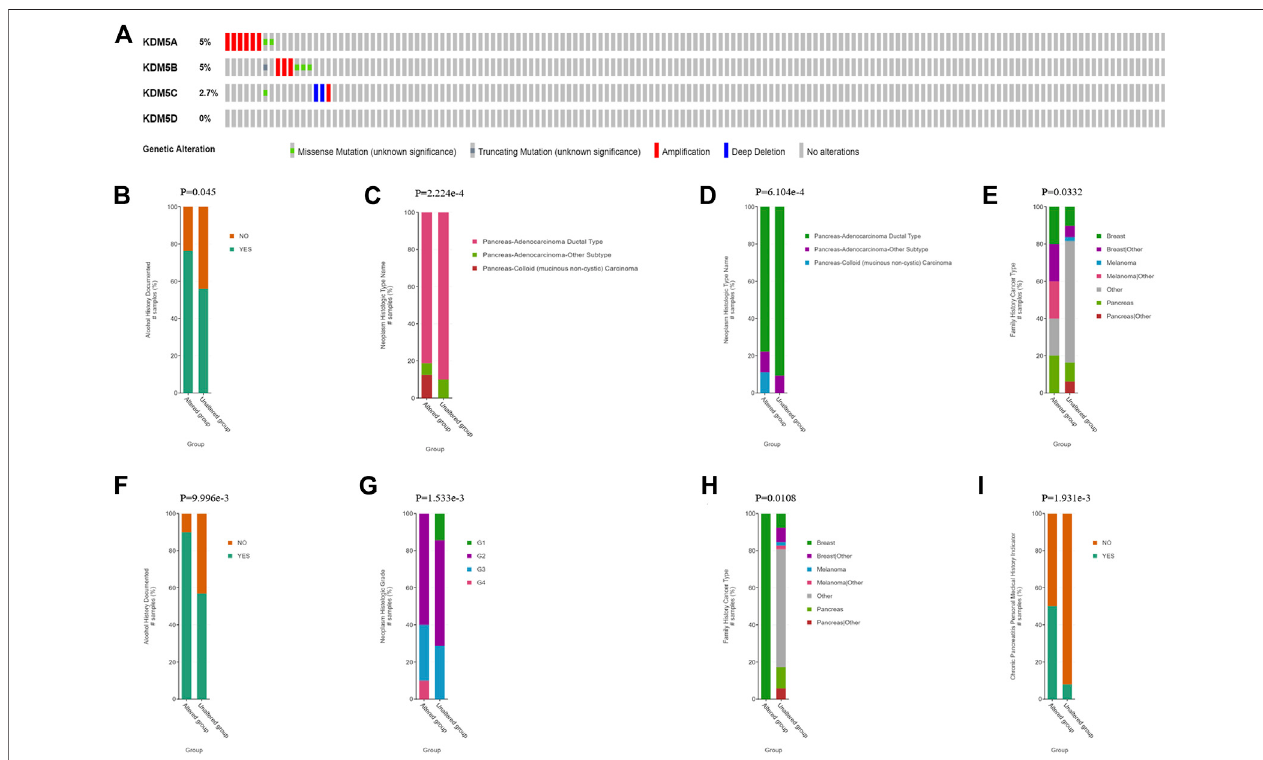
FIGURE 2 | KDM5 family gene mutations and clinical and prognostic characteristics in patients with PAAD. (A) KDM5 family mutations in pancreatic cancer; (B) PancreaticcancerpatientswithahistoryofdrinkingaremorelikelytoundergoKDM5familygenemutation; (C) Pancreaticmucinousadenocarcinomapatientsaremore likely to undergo KDM5 family genes mutation; (D) Pancreatic cancer patients with a family history of breast cancer and melanoma are more likely to undergo KDM5A gene mutation; (E) Pancreatic mucinous adenocarcinoma patients are more likely to undergo KDM5A gene mutation; (F) Pancreatic cancer patients with a history of drinking are more likely to undergo KDM5B gene mutation; (G) Pancreatic cancer patients with a family history of breast cancer are more likely to undergo KDM5C genemutation; (H) PancreaticcancerpatientswithahistoryofchronicpancreatitisaremorelikelytoundergoKDM5C genemutation; (I) Pancreaticcancerpatientswith a higher pancreatic cancer tumor grade are more likely to undergo KDM5C gene